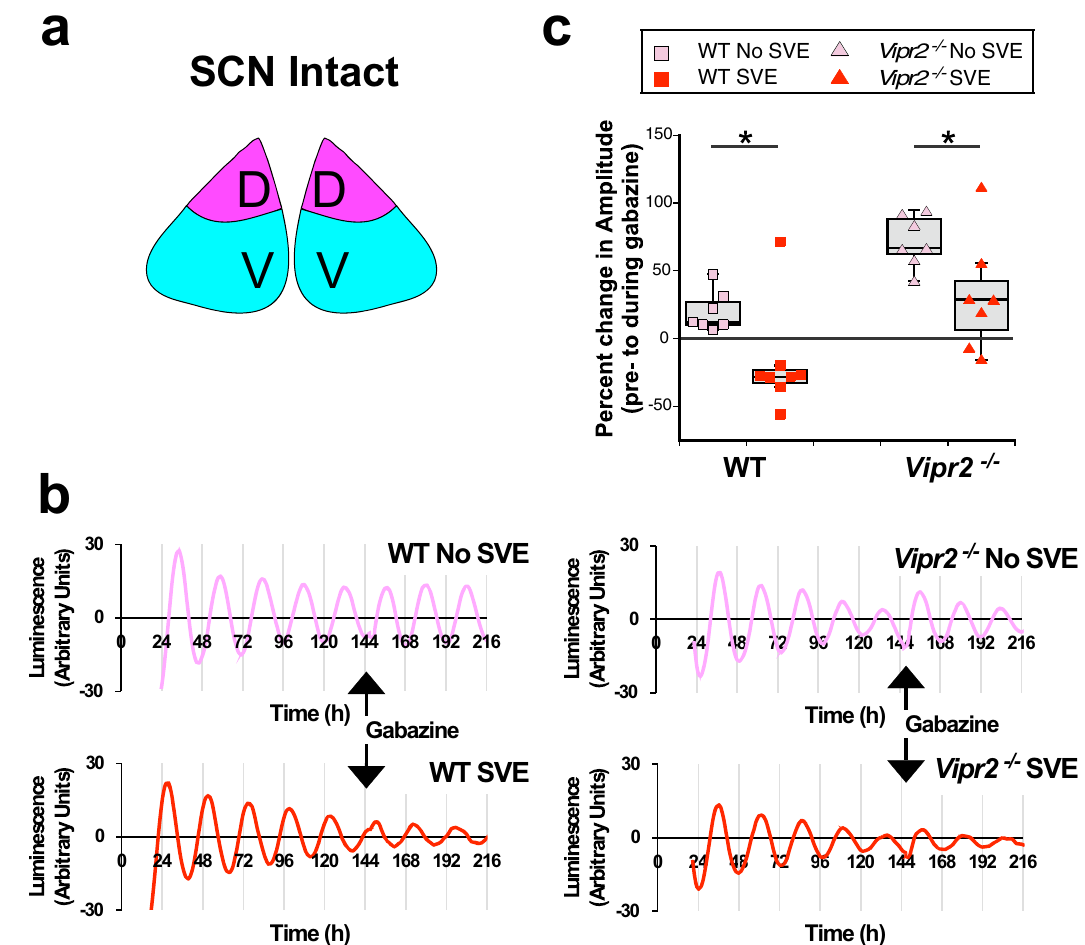
Fig. 7 SVE reduces GABAergic in fl uences on PER2 rhythms in the intact SCN. a Schematic diagram of intact SCN. b , c Gabazine treatment evoked signi fi cant increases in PER2::LUC rhythm amplitude in intact SCN (pink and blue fi lled diagram insert) from non-SVE WT and Vipr2 − / − mice. This was abolished and signi fi cantly reduced in post-SVE tissue from WT and Vipr2 − / − SCN, respectively (percent changes in amplitude during gabazine treatment: WT non-SVE 20.0 ± 5.6% vs. WT SVE − 19.2 ± 13.5%, p = 0.024; Vipr2 − / − non-SVE 72.1 ± 7.2% vs. Vipr2 − / − SVE 31.9 ± 16.2%, p = 0.025. All ANOVA with planned comparisons). WT ( mPer2 luc ): non-SVE, n = 7 and SVE n = 8 and Vipr2 − / − ( Vipr2 − / − , mPer2 luc ): n = 7 each, non-SVE and post-SVE. Abnormal increases in amplitude of non-SVE Vipr2 − / − SCN in response to GABA A receptor blockade are reduced to WT-like responses in post-SVE Vipr2 − / − SCN. Gray shaded boxes in c represent the interquartile distance between the upper and lower quartile with the median plotted as a horizontal line within the box. Whiskers depict the lower quartile − 1.5 × interquartile distance and upper quartile + 1.5 × interquartile distance. Individual data points are overlaid. * p = 0.05. See also Figs. S3 and S4. D and V in diagram inserts label dorsal SCN and ventral SCN,